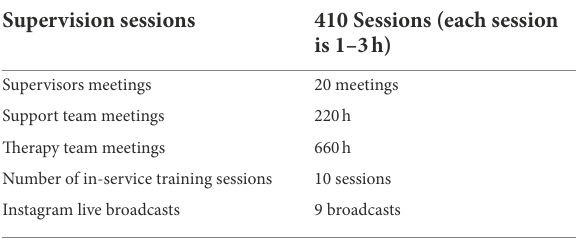
TABLE 2 Therapist support meetings and durations. TABLE 1 Baseline characteristics of